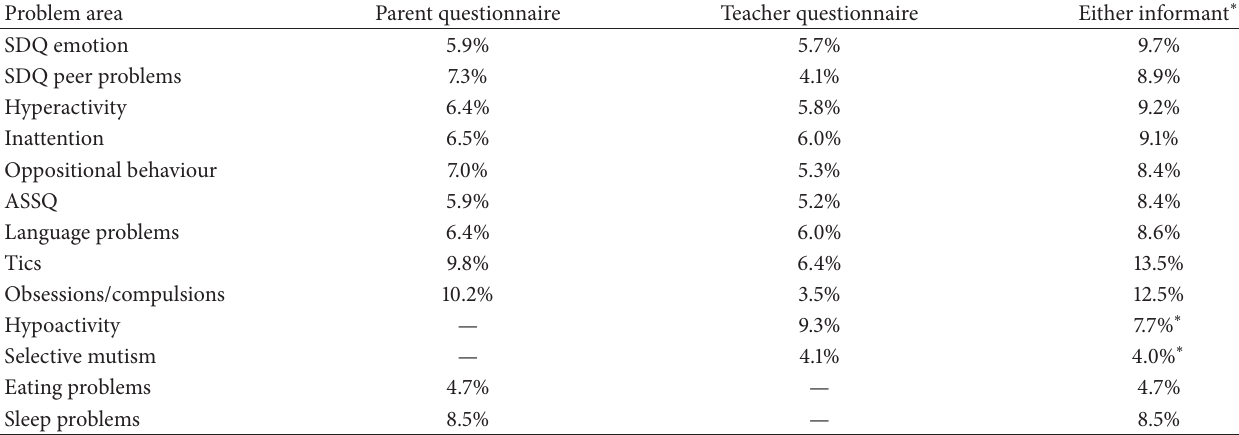
Table 1: Problem areas and actual percentages of children scoring above the 95th percentile on parental and teacher